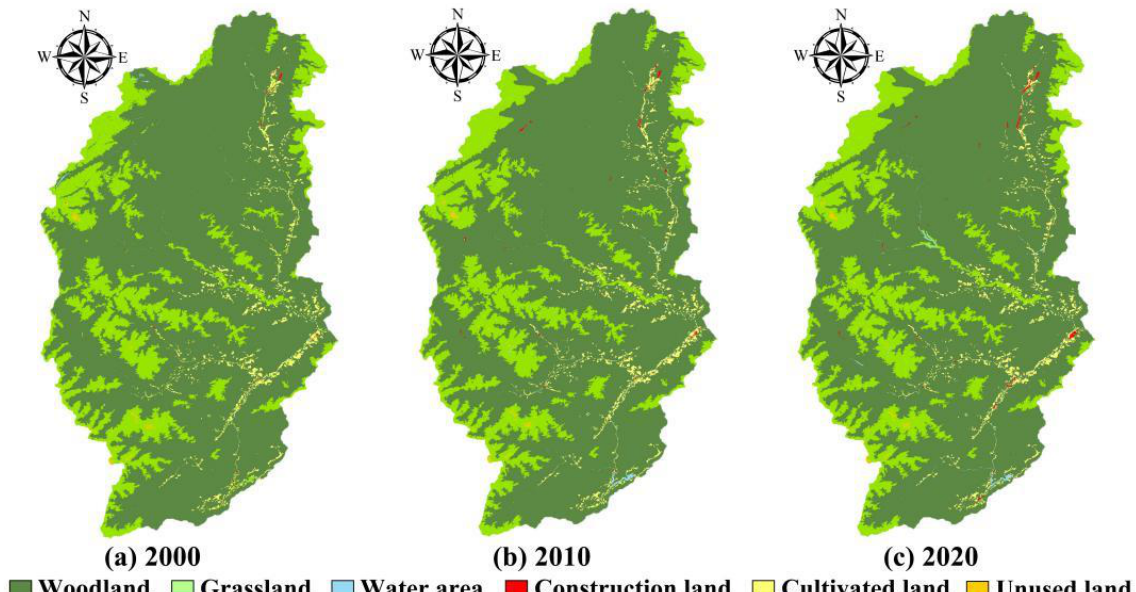
Figure 3. Land-use change from 2000 to 2020: ( a ) 2000, ( b ) 2010, ( c ) 2020